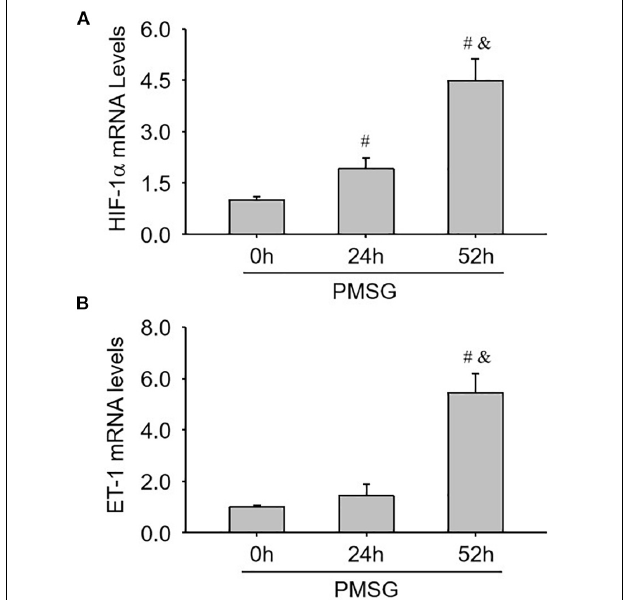
FIGURE 8 | Expression changes of HIF-1 α and ET-1 mRNA in the ovaries during the follicular development induced by PMSG. (A) The relative mRNA levels of HIF-1 α by real-time PCR analysis. (B) The relative mRNA levels of ET-1 by real-time PCR analysis. Each value represents the mean ± SE. One-way analysis of variance (ANOVA) was used to analyze the data, followed by a Tukey’s multiple range test. n = 6. # P < 0.05, vs. PMSH-0 h; & P < 0.05, vs. PMSH-24